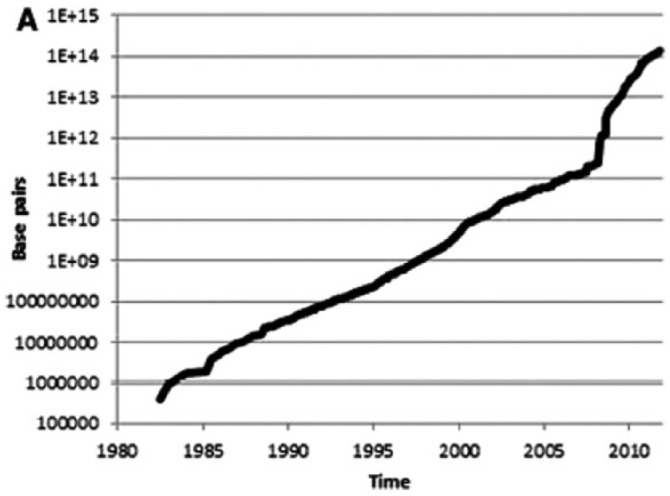
Cumulative base pairs in INSDC over time (Karsch-Mizrachi et al., 2012: Figure 2).